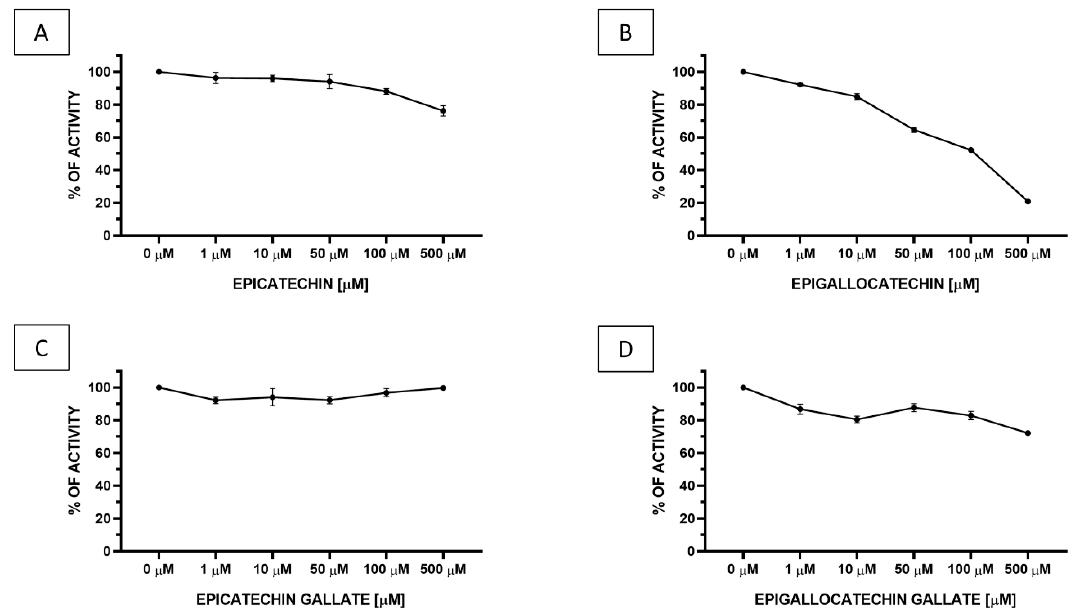
Figure 1. Enzymatic activity of PTP1B after 30 min of treatment with different concentrations of ( A ) epicatechin, ( B ) epigallocatechin, ( C ) epicatechin gallate, and ( D ) epigallocatechin gallate. The results were presented as a percentage of control as means ± SD ( n = 3).